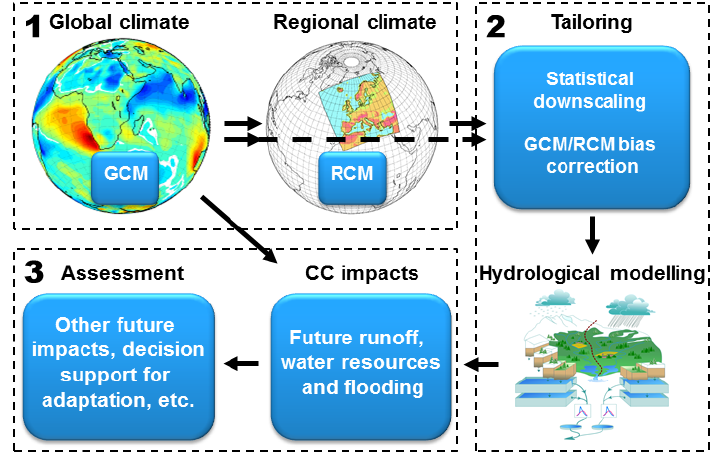
Figure 1. The three main steps typically included in hydrological climate change impact assessment: ( 1 ) climate modelling (global and regional); ( 2 ) tailoring and hydrological modelling; ( 3 )